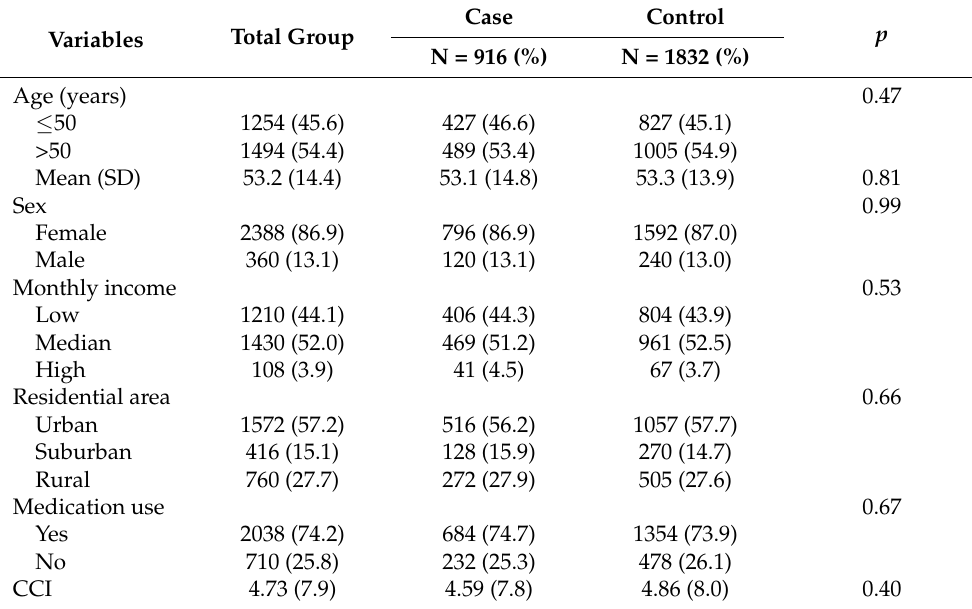
Table 1. Demographic data and selected comorbidities between two